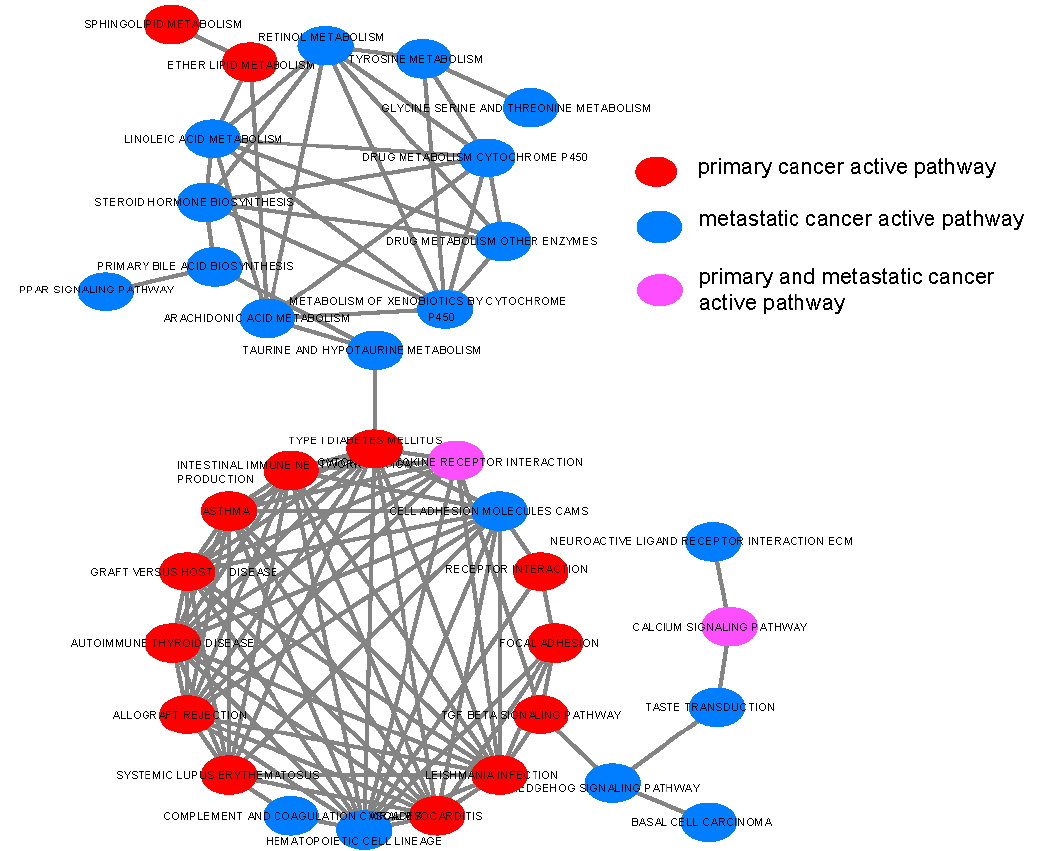
Figure 4. Pathway connections among 35 significantly differentially-active pathways in the general condition (general condition means in the raw KEGG pathways).